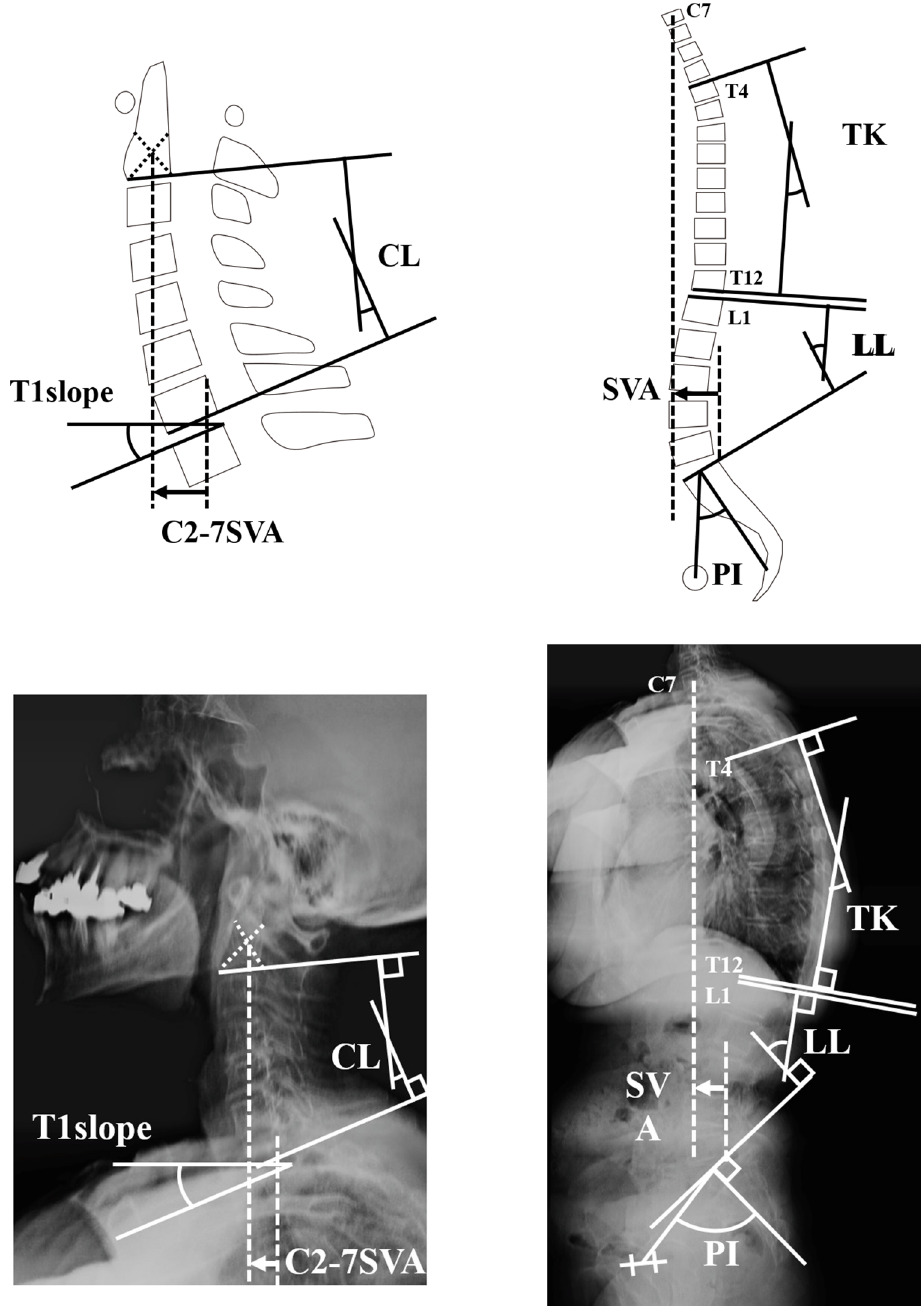
Figure 1. Radiographic